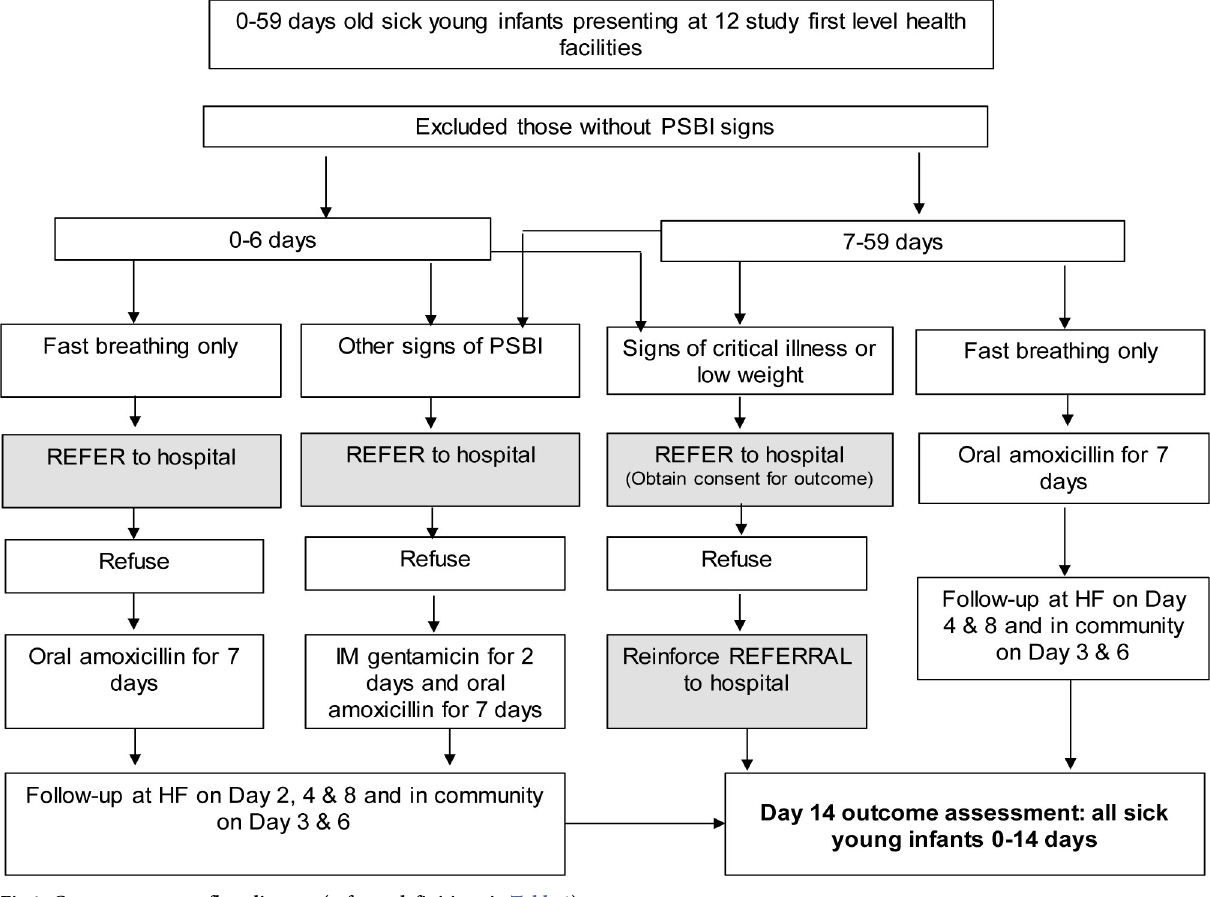
Fig 1. Case management flow diagram (refer to definitions in Table